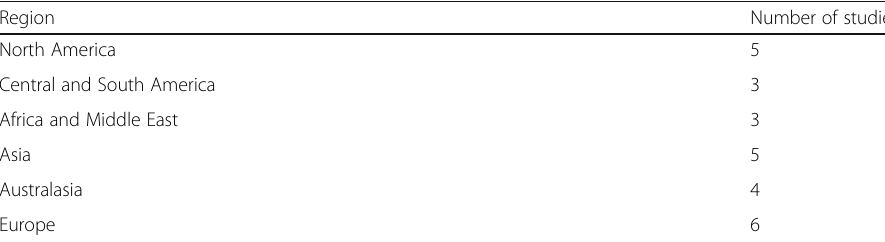
Table 5 Empirical studies by geographical region